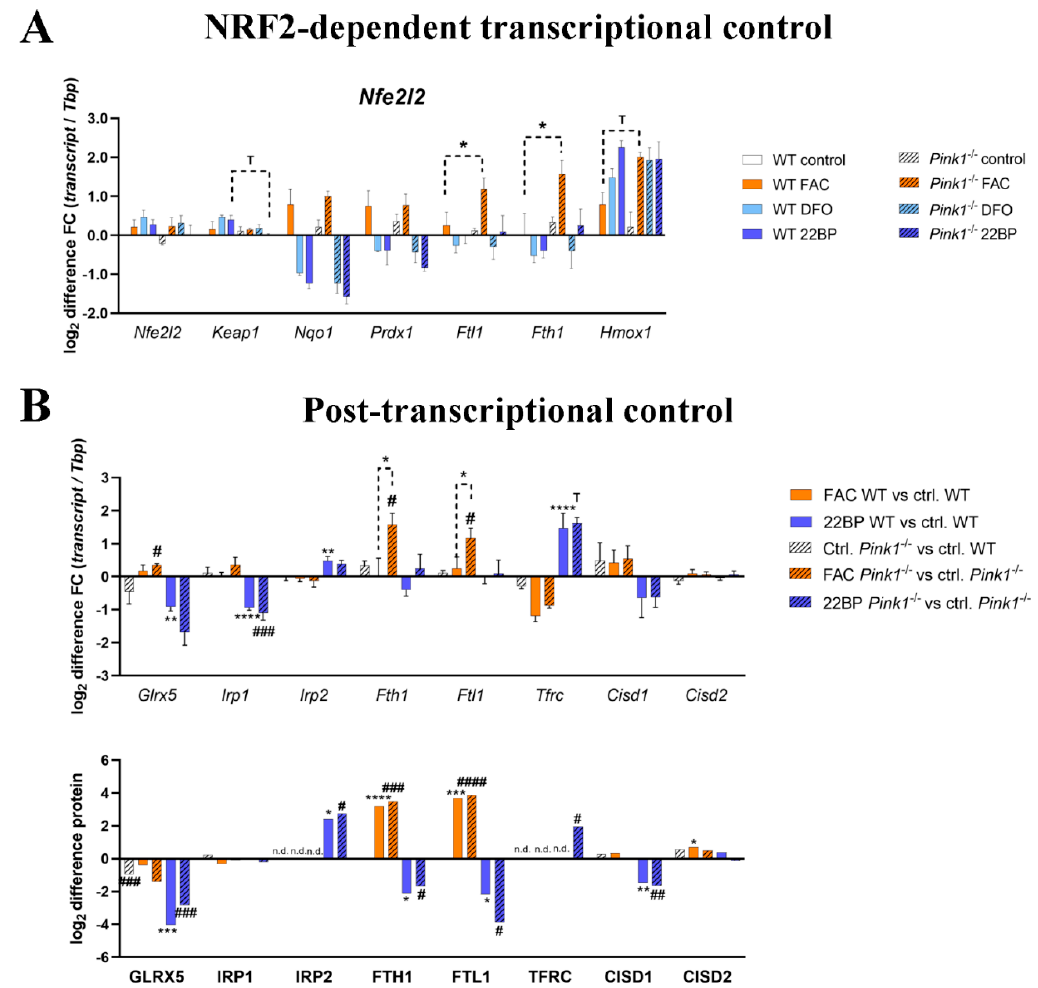
Figure 6. Adaptation to changing iron concentrations for key factors in (A) the Nuclear factor, erythroid 2 like 2, Nfe2l2 (NRF2) transcription factor complex with its modulator Kelch-like ECH associated protein 1 (KEAP1) and their downstream transcript targets, as well as (B) the post-transcriptional control of iron import and storage. For mRNA expression analysis, the Tbp levels were used as loading control and after normalizing the fold changes to control conditions in WT MEF, the log 2 fold changes of individual fold changes were calculated. The fold change of protein abundance label free quantification (LFQ) value was also represented as log 2 difference. Mutant cells are represented by dashed bars, WT cells by plain colors. Asterisks represent significance in WT MEF, treated versus untreated control, while hashtags refer to Pink1 − / − MEF, treated versus untreated control. To simplify the overview, in (A) only genotype-dependent significances are shown, whereas (B) includes all significances with respect to control conditions. Detailed p -values and individual fold changes can be seen in Supplementary Tables S1,2. The statistical trends or levels of significance are illustrated by symbols T: 0.1 > p >0.05, * or #: p < 0.05, ** or ##: p < 0.01, *** or ###: p < 0.001, **** or ####: p < 0.0001.